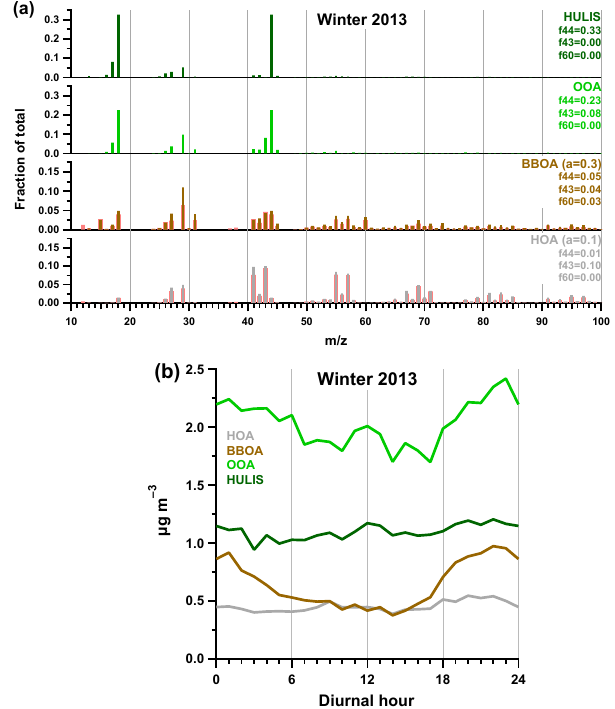
Figure 5. (a) Mass spectra of ACSM PMF factors and (b) average diurnal variations (LT) of ACSM factors found in winter 2013. For the constrained profiles HOA and BBOA, the applied a value is written in brackets. Corresponding reference spectra are shown by red bars. Note that the y axis scales of the POA profiles are zoomed by a factor of 2 compared to SOA